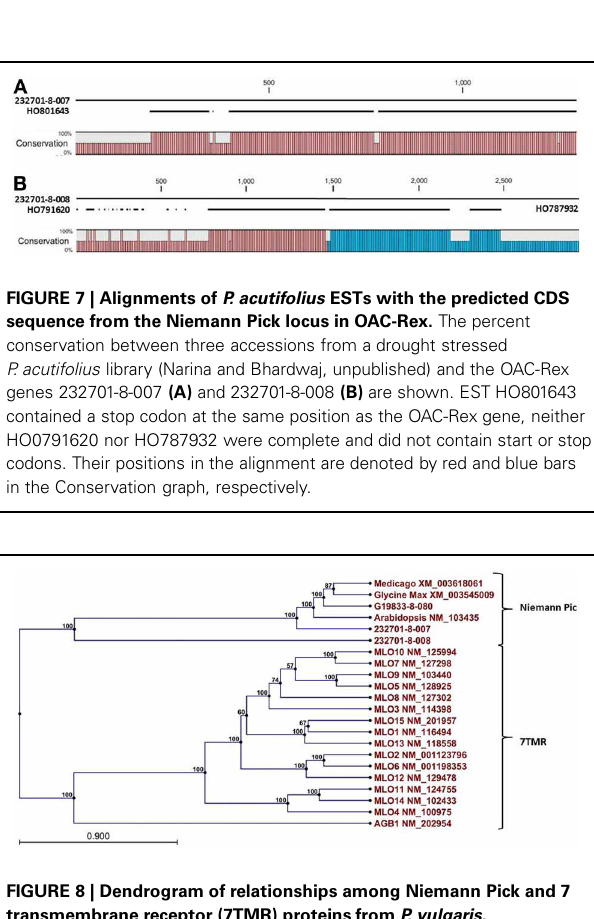
FIGURE 10 | Comparison of the resistance gene candidates from G19833 chromosome 8 and OAC-Rex contig 231733. (A) An alignment of the G19833 region containing G19833-8-009 with the OAC-Rex region containing a homolog 231733-8-002 showing an insertion containing a unique gene fragment and two complete R-gene analogs 231733-8-004 and 231733-8-005. (B) Alignments of the predicted protein products of OAC-Rex genes 231733-8-002, 231733-8-004, and 231733-8-005 with the G19833-8-009 gene. The level of conservation among the 4 genes is indicated by the Conservation bar graph. The positions of nucleotide binding sequences (NBS), leucine rich region (LRR) domains, and the Thermal Unstable (TU) elongation factor domains are shown on the